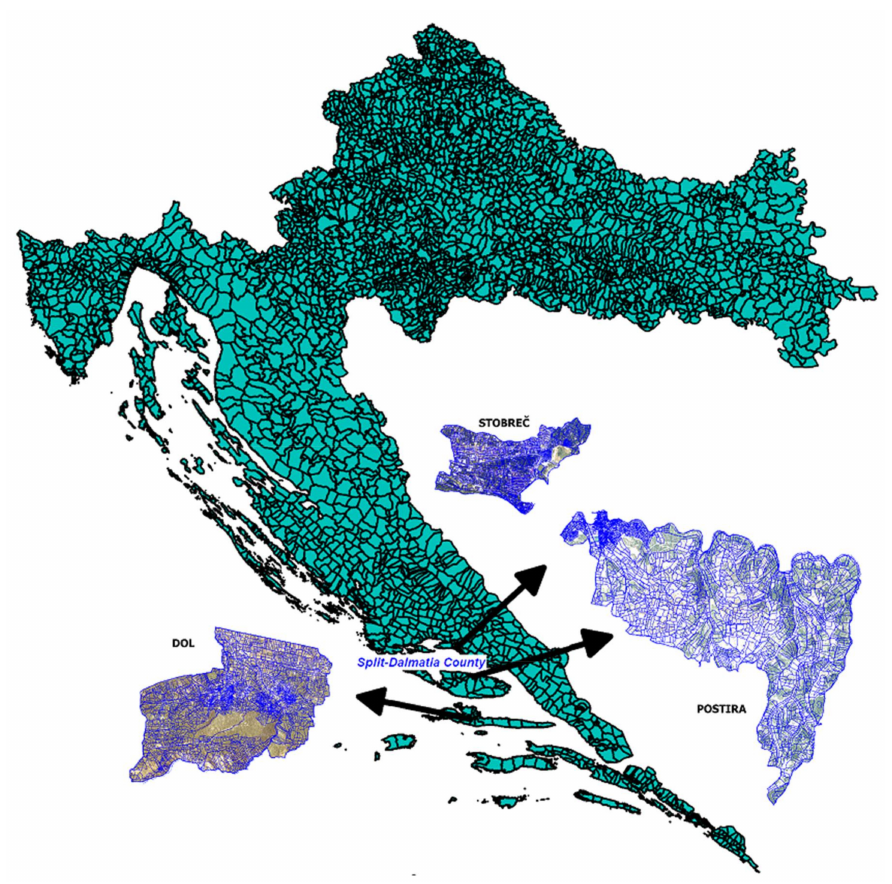
Figure 2. Research areas. Source: own